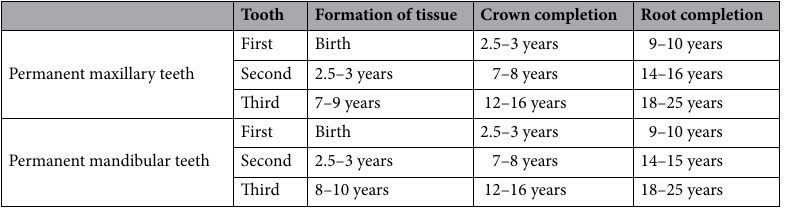
Table 2. Summary of molar formation 82